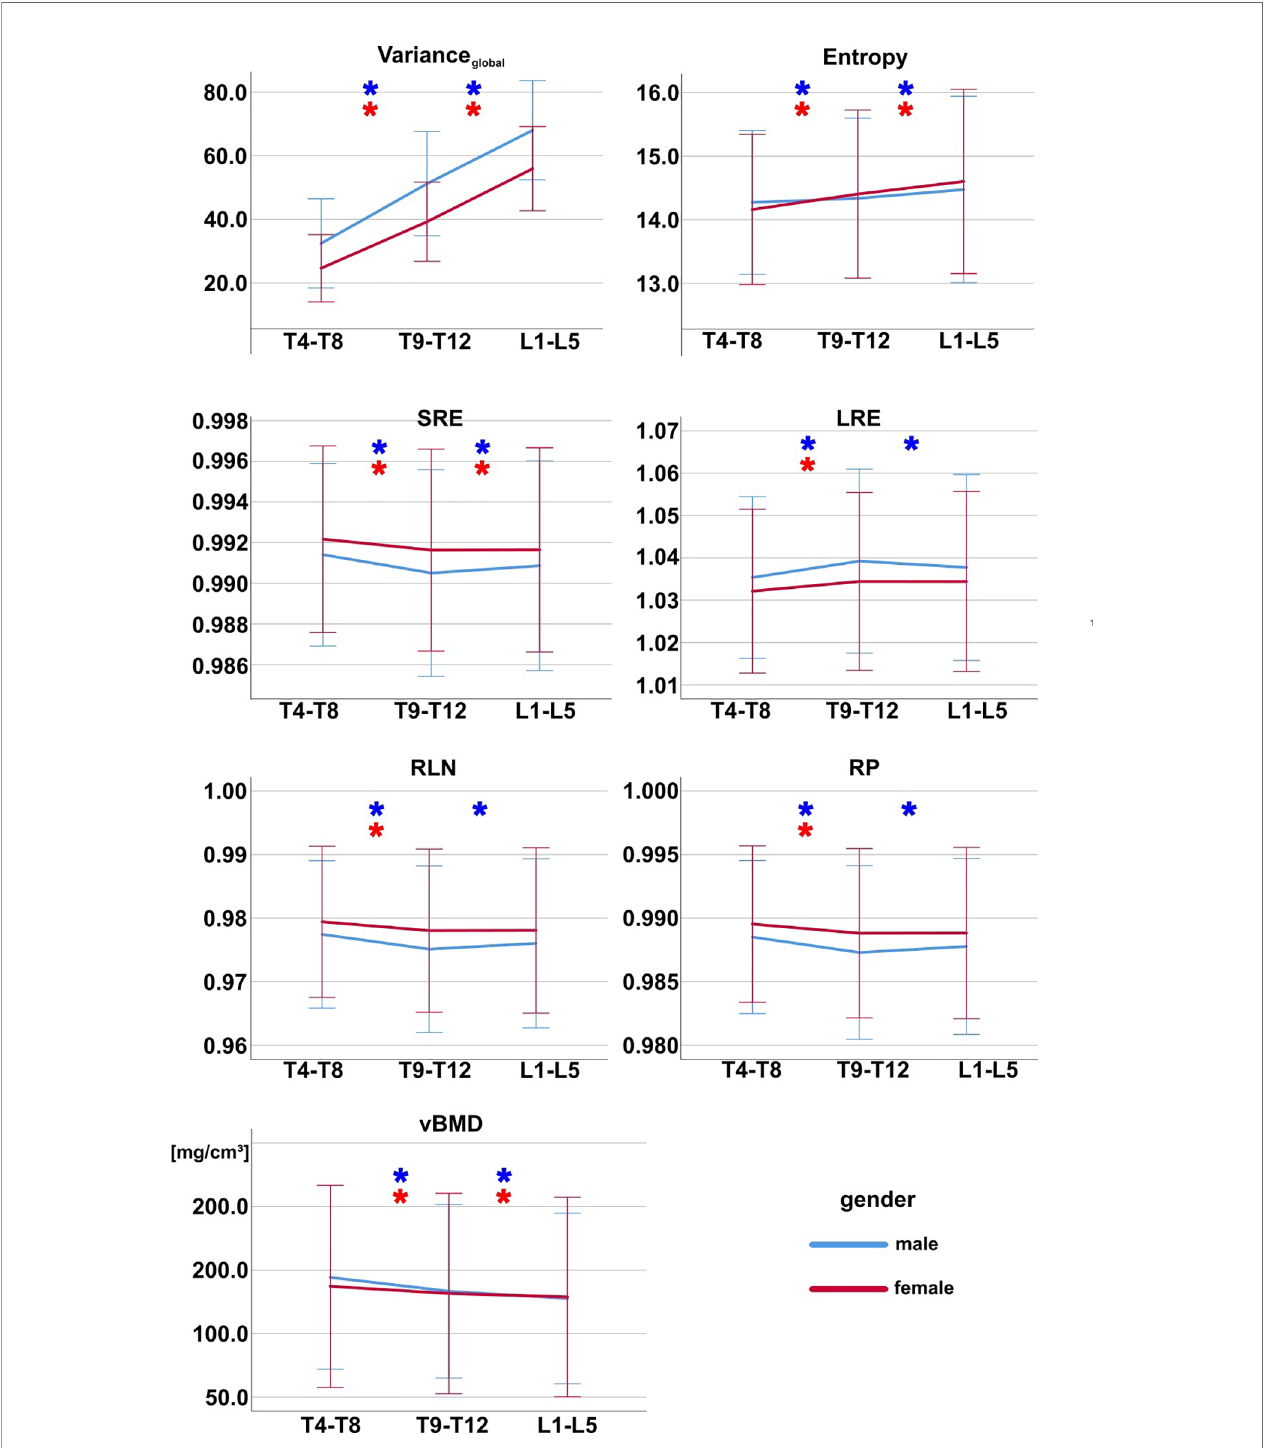
FIGURE 3 | Texture features and vBMD grouped by spine region for females (red) and males (blue). Asterisks (*) mark pairwise signi fi cant differences between spine regions. Bonferroni correction was applied to adjust for multiple comparisons. Error bars indicate ± 2 standard deviations. SRE, short-run emphasis; LRE, long-run emphasis; RLN, run-length non-uniformity; RP, run percentage; vBMD, volumetric bone mineral